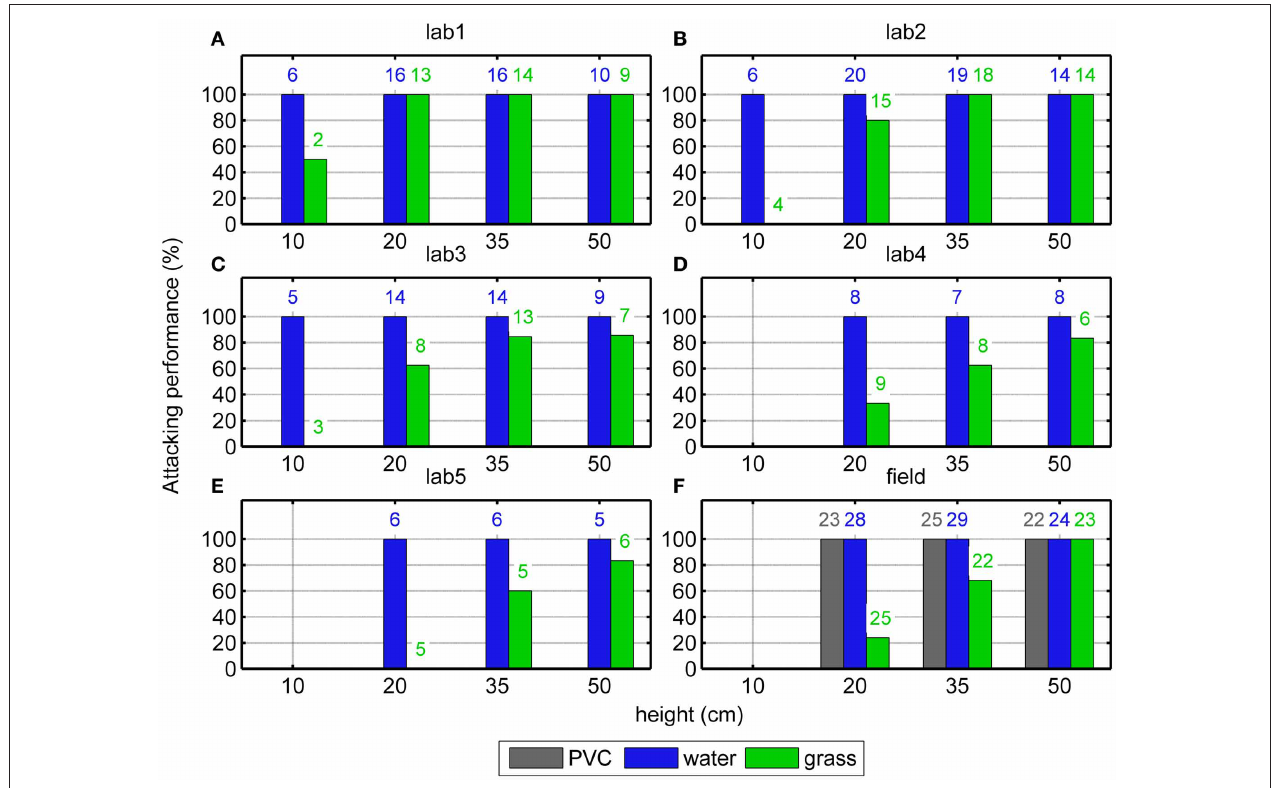
FIGURE 2 | Attacking performance above different surfaces at different heights. The results from 5 bats in the laboratory (“lab1-5”, A–E ) and from the field (”field”, F ) show that the bats always attacked one of the targets when it